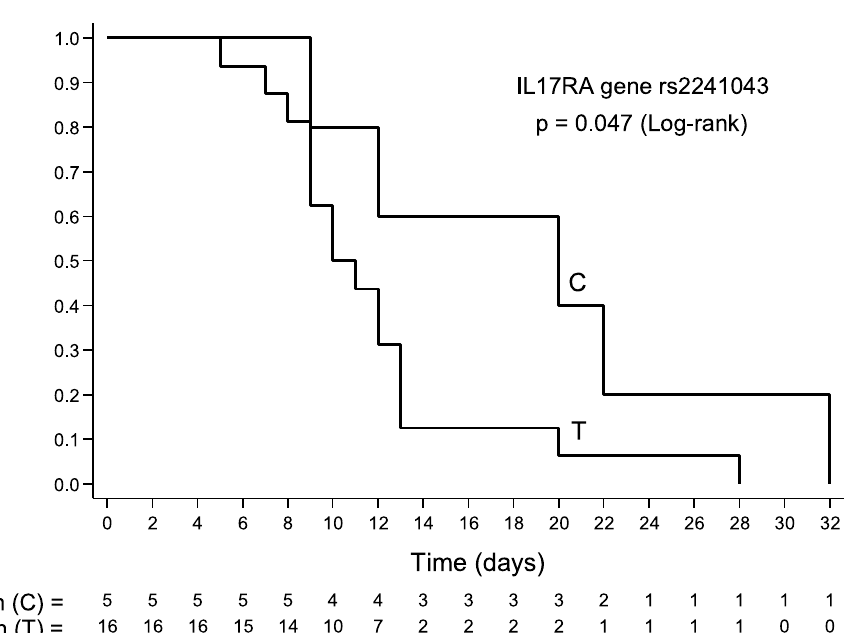
Fig. 1 IL17RA gene rs2241043 (C/T) and association with longest survival time in the non‑pandemic group concerning the C